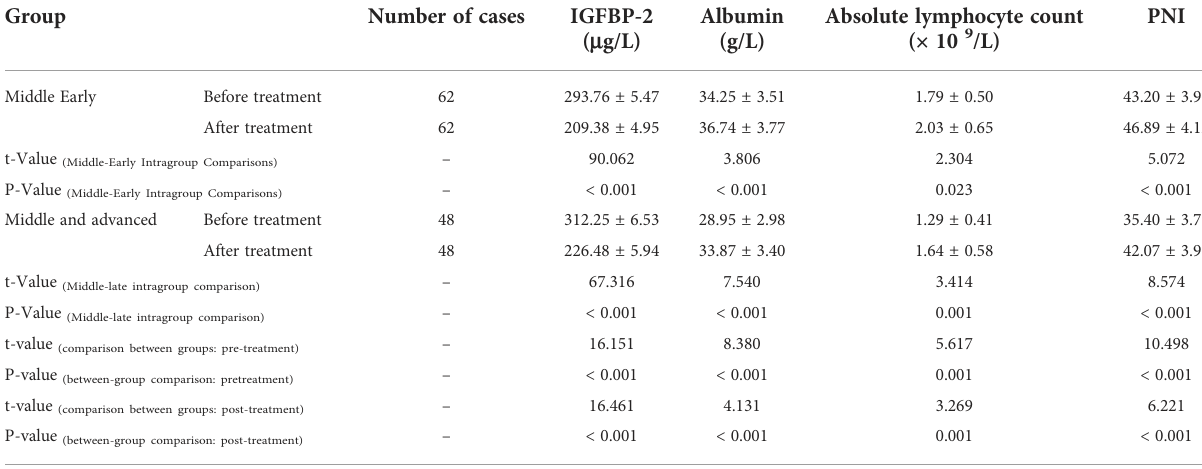
TABLE 3 Comparison of IGFBP-2, albumin, absolute lymphocyte and PNI values in patients with different TNM stages [x ̅ ± s]. Group